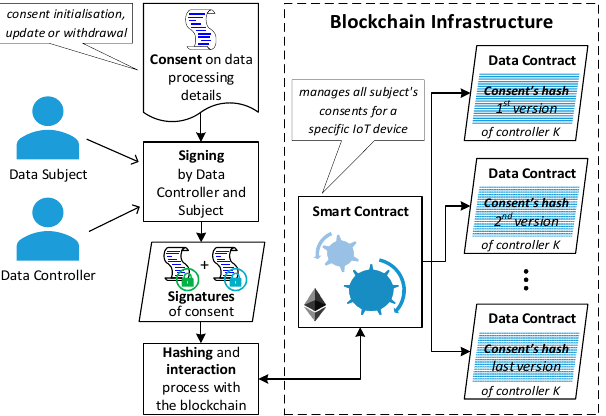
Figure 3. The steps followed by the consent notary component to ensure integrity, non-repudiation, and versioning of given contents.